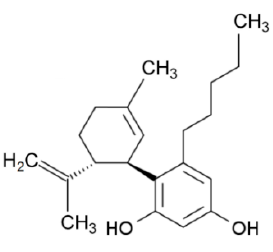
Figure 4. Chemical structure of abnormal-cannabidiol.